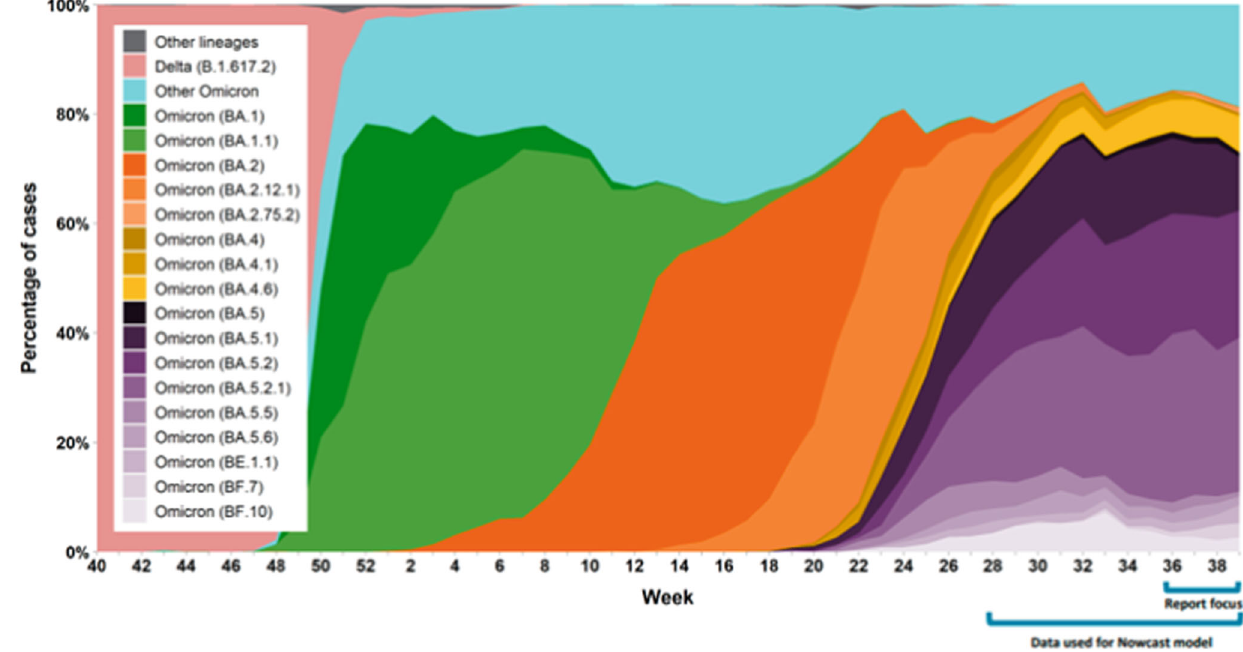
Fig. 4 | Percentage ofCOVID-19 casesby the most prevalent lineagesand week in Ontario from October 3, 2021 to October 1, 2022. Percentage of COVID-19 cases by the most prevalent lineages and week, representative surveillance, Ontario, October 3, 2021 to October 1, 2022 27 . Each color represents a different lineage or sublineage of Omicron. Note: results may not be representative of Ontario overall, particularly in earlier weeks. Week was assigned based on